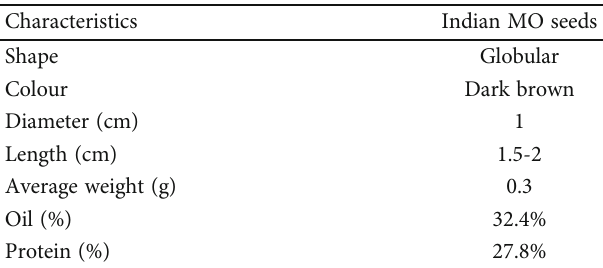
Table 2: The morphological and qualitative characterization of MO